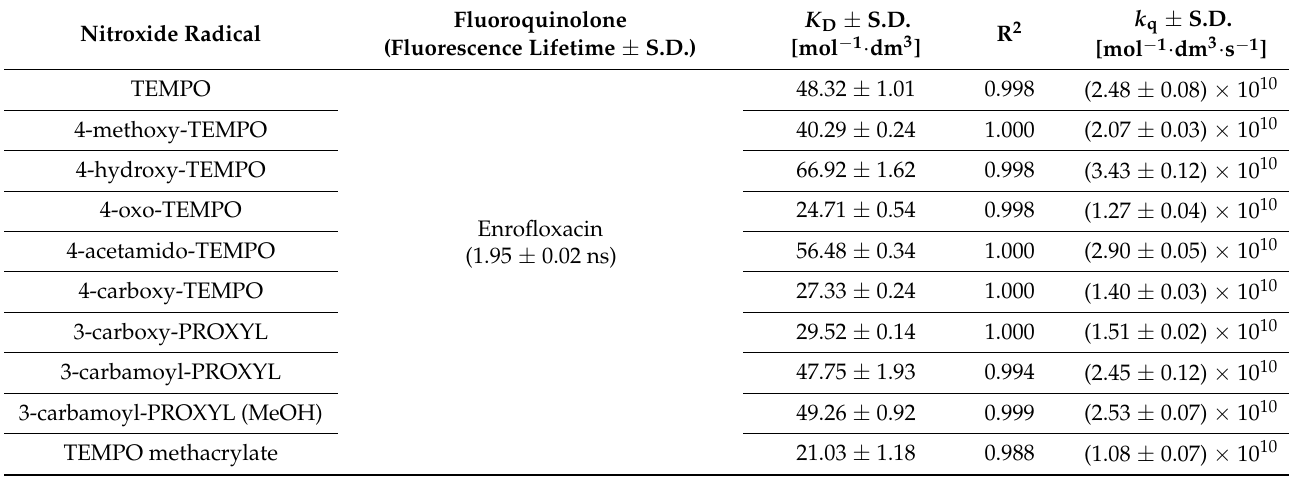
Table 1. Stern–Volmer dynamic quenching constants ( K D ), linear correlation coefficients (R 2 ) and bimolecular quenching rate constants ( k q ) recovered for the steady-state fluorescence quenching of the studied fluoroquinolones by various TEMPO and PROXYL nitroxides in aqueous solutions at 20 ◦ C. The results are shown as a mean ± standard deviation (S.D.) of three independent